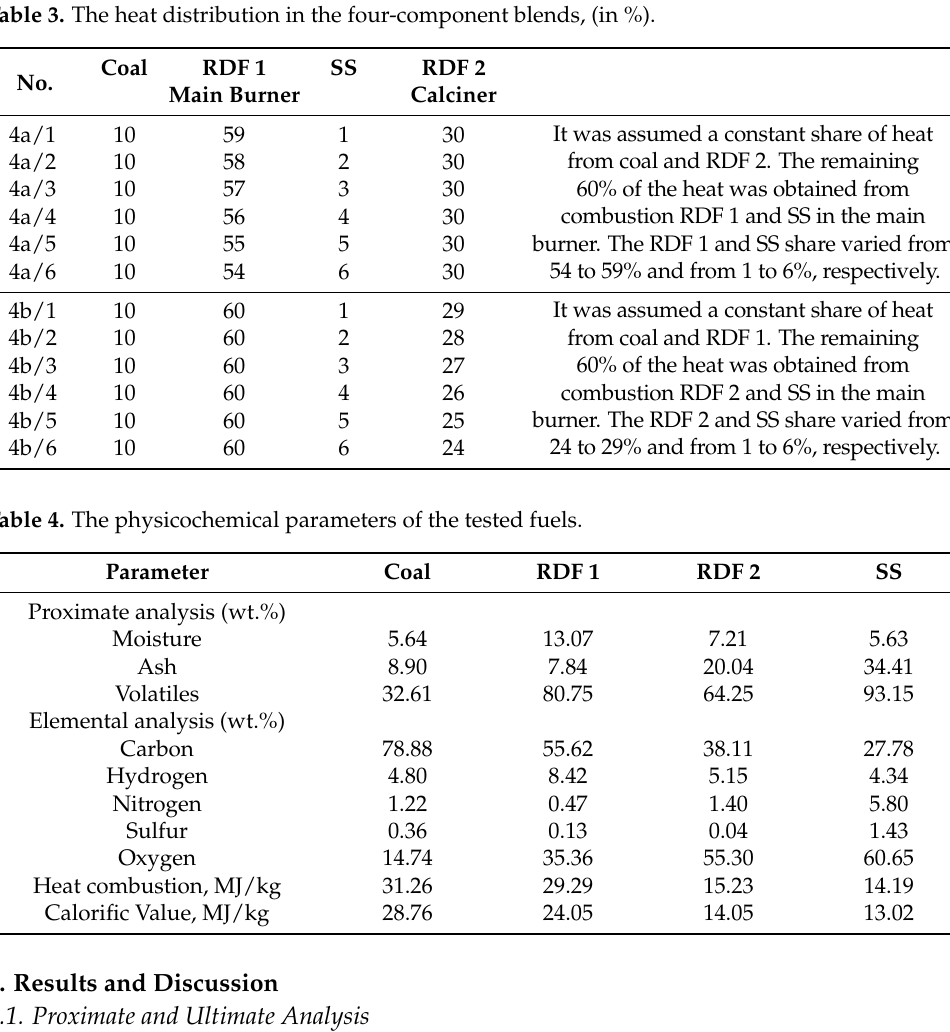
Table 3. The heat distribution in the four-component blends, (in %). Coal RDF 1 SS RDF 2 No. Main Burner Calciner